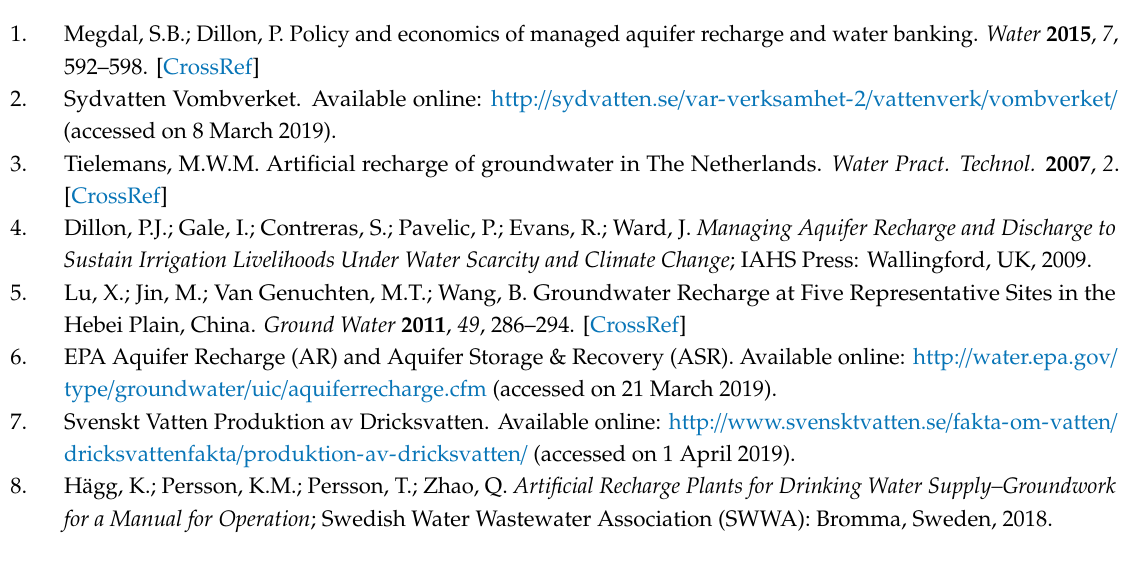
Figure S1: COD measurements at di ff erent stages along the two treatment processes (mg / L). The middle bar is the mean value and the top and lower bars show the standard deviation. The dotted line is the contact filter treatment process and the solid line is the control treatment process.; Figure S2: UVA 254 nm at di ff erent stages along the two treatment processes. The middle bar is the mean value and the top and lower bars show the standard deviation. The dotted line is the contact filter treatment process and the solid line is the control treatment process.; Figure S3: Changes in algae types in the two treatment processes, the biomass scale is the area covered by algae, i.e., 1 = 10%, 2 = 20%, and so on.; Figure S4: Microcystin concentrations at di ff erent treatment processes; Table S1: Water quality at di ff erent stages along the treatment processes and changes in the toxin data; Table S2: Global amount of cyanobacteria in di ff erent steps of the pretreatment